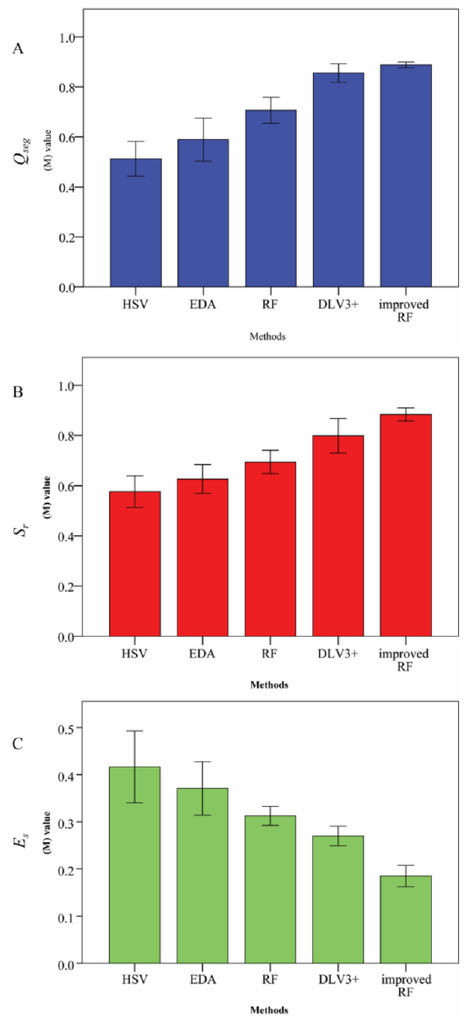
Figure 4. Comparison of the mean accuracy rate ( Q seg , S r , and E s ). Comparison of the segmentation quality for the hue-saturation-value (HSV), edge-detection-based algorithm (EDA), random forest (RF), DeepLabv3 + , and the proposed method (improved RF). The color bars indicate the mean value of the indices, and the black lines represent their standard deviations.